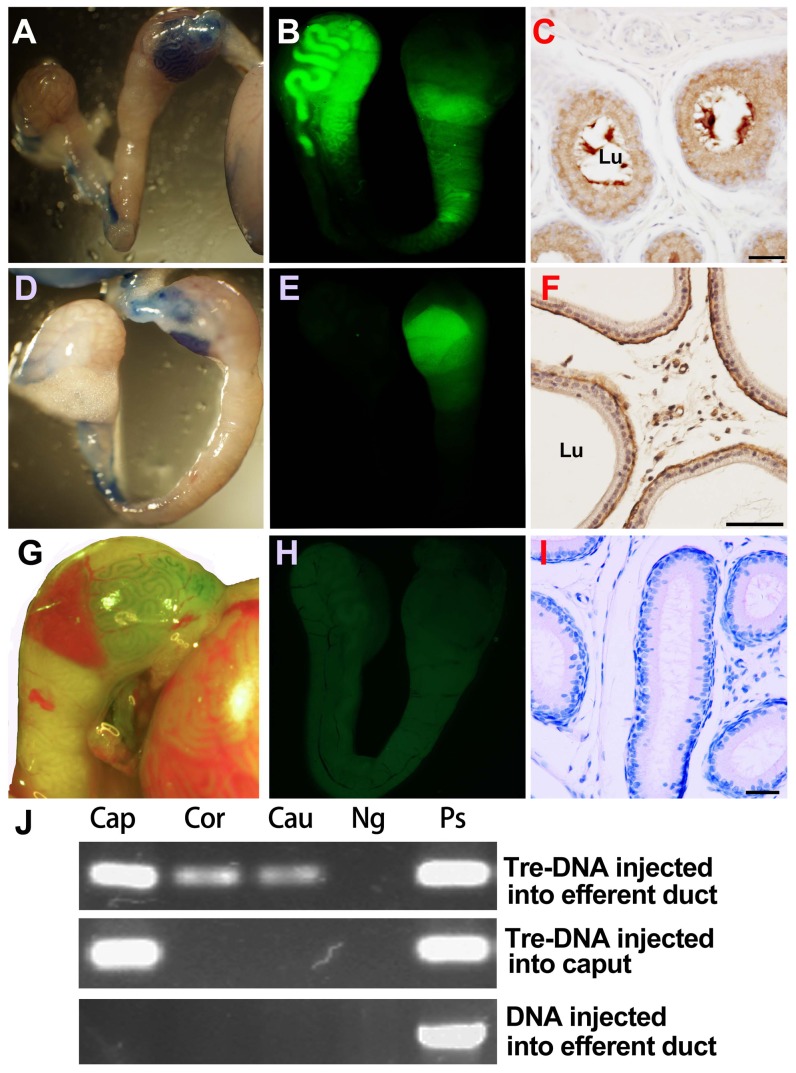
Effects of trehalose on transfer of pEGFP-C1 into the mouse epididymis in vivo.A, B, and C) fluorescence appeared in different segments of mouse epididymis at 3rd day after the complex of trehalose-DNA was injected into mouse efferent duct. A) The morphology of mouse epididymis after injecting the complex. B) The mouse epididymis under fluorescence microscopy; C) Localization of GFP protein in epithelial cells and lumen of epididymal caput by immunohistochemistry. D, E, and F) fluorescence only appeared in mouse epididymal caput at 3rd day after Tre-DNA was injected into mouse epididymal caput interstitial tissue. D) The morphology of mouse epididymis after injecting the complex in light view. E) The mouse epididymis under fluorescence microscopy; F) GFP protein expressed in epithelial cells and intercellular cells of epididymal caput by immunohistochemistry. G, H, and I) Little fluorescence appeared in different segments of mouse epididymis at 3rd day after the pEGFP-C1 plasmid was injected into mouse efferent duct. G) The morphology of mouse epididymis after injecting the plasmid in light view. H) The mouse epididymis under fluorescence microscopy; I) No GFP positive signal appeared in the epididymal caput by immunohistochemistry. Bar: 40 μm. J) GFP mRNA expression was detected in mouse epididymal caput, corpus and cauda at 3rd day after treatment by RT-PCR.